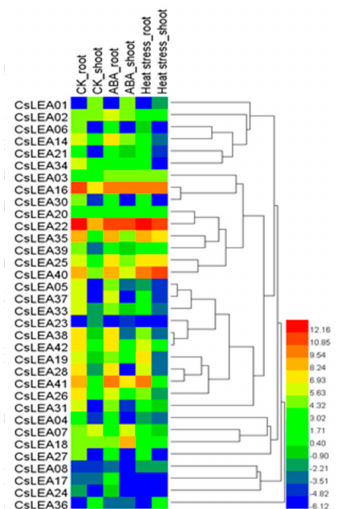
Figure 5. Hierarchical clustering of CsLEA gene expression profiles in root and shoot tissues after 24 h heat or ABA treatment. The log transformed values for the relative expressions of CsLEA genes were used for the hierarchical clustering analysis. The blue scale means low transcript expression and the red scale means high transcript